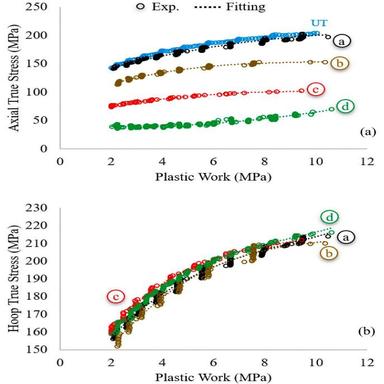
The calculated principal stresses for different levels of plastic work for uniaxial tension and biaxial tension deformation modes: a) Axial stress and b) Hoop stress with respect to the plastic work (The experimental data were fitted using polynomial functions).